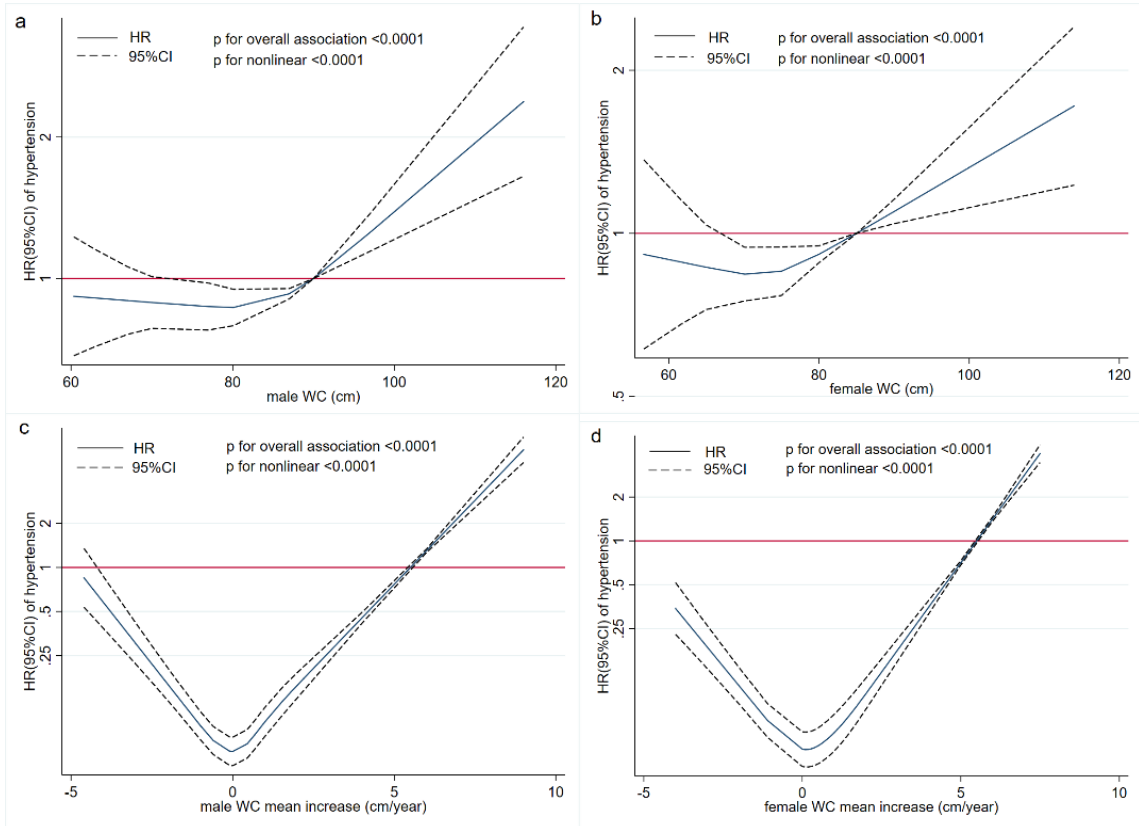
Figure 4. Exposure − response associations of WC and mean annual increase in WC with risk of hypertension by restricted cubic spline for adjusted Cox proportional hazards analysis. ( a , b ) the associations of WC with risk of hypertension in males and females, respectively. ( c , d ) The associations between mean annual increase in WC and risk of hypertension in males and females, respectively. The red line is the reference line when HR is 1.